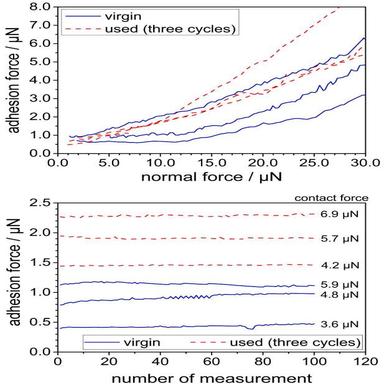
Single particle adhesion force of virgin and used PA12 powder at 21 ◦C for (top) a measurement mode with steadily rising normal force during particlesubstrate contact prior to separation and (bottom) repeated measurements with an almost constant normal force during particle-substrate contact.